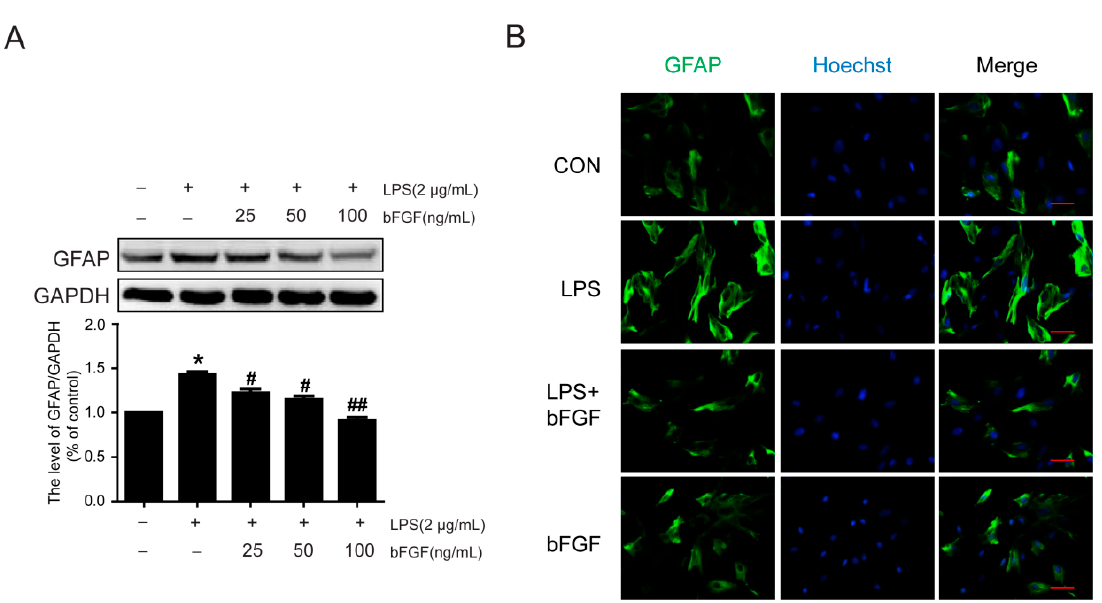
Figure 3. Effect of bFGF on GFAP expression in astrocytes that were stimulated by LPS. LPS (2 µg/mL) was used to induce the activation of astrocytes for 24 h. Then, the effect of bFGF on astrocyte activation was investigated. ( A ) Western blot of GFAP at different concentrations of bFGF (25, 50, and 100 ng/mL); ( B ) Immunofluorescence of GFAP. * p < 0.05 versus CON, # p < 0.05, ## p < 0.01 versus LPS. All results represent at least three independent experiments; Scale bar is 50 µm.